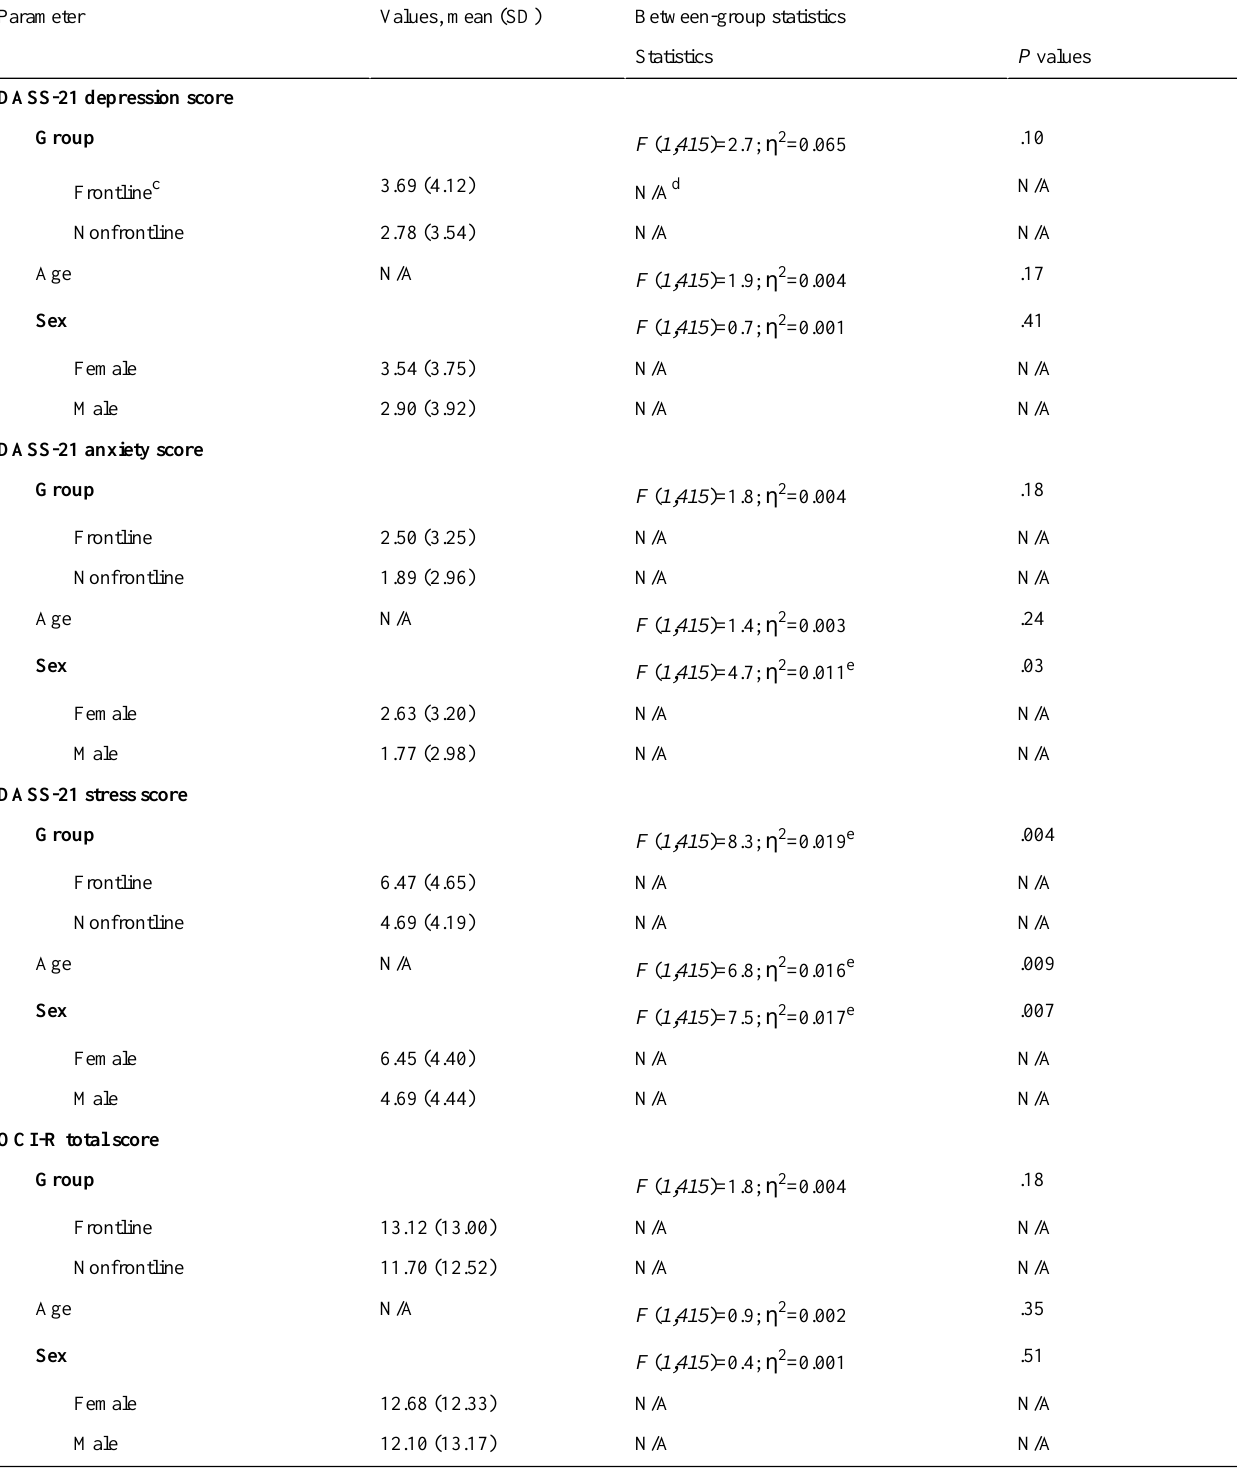
Table 2. Results of the analysis of covariance between Portuguese physicians at the frontline (n=200) and those not at the frontline (n=220) during the COVID-19 pandemic (May 4-25, 2020) with respect to the DASS-21 a and OCI-R b scales, using age and sex as